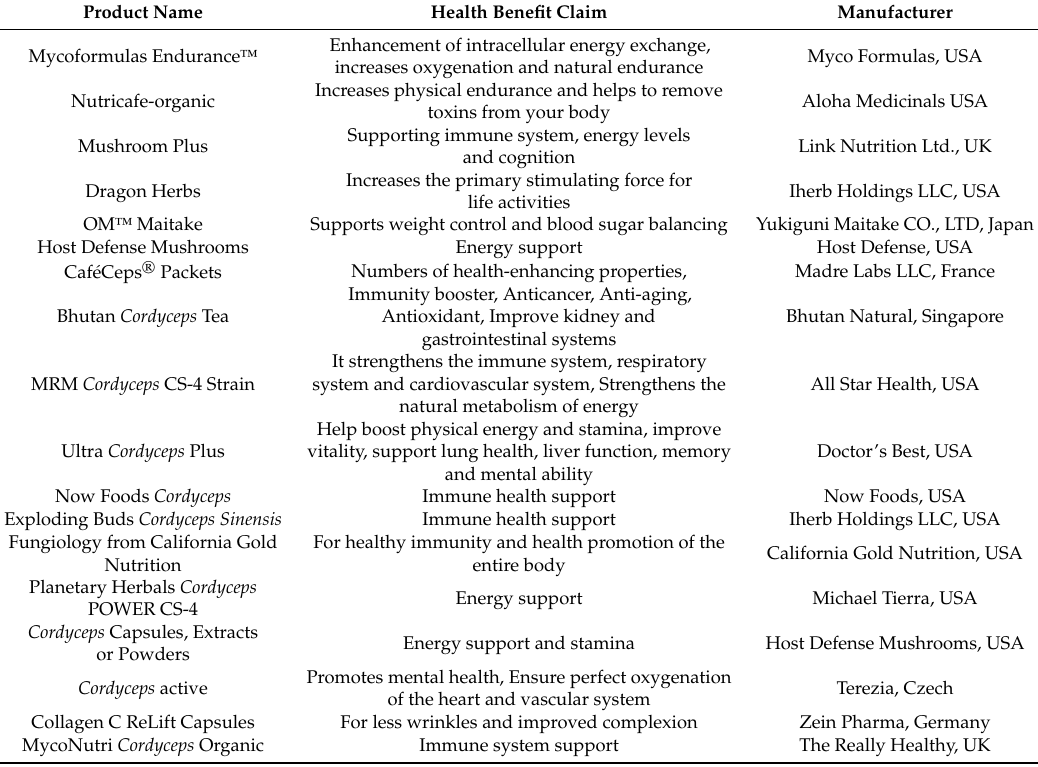
Figure 3. Pictorial representation of Cordyceps therapeutic potential in general. Table 2. Nutraceutical products from Cordyceps available on the global